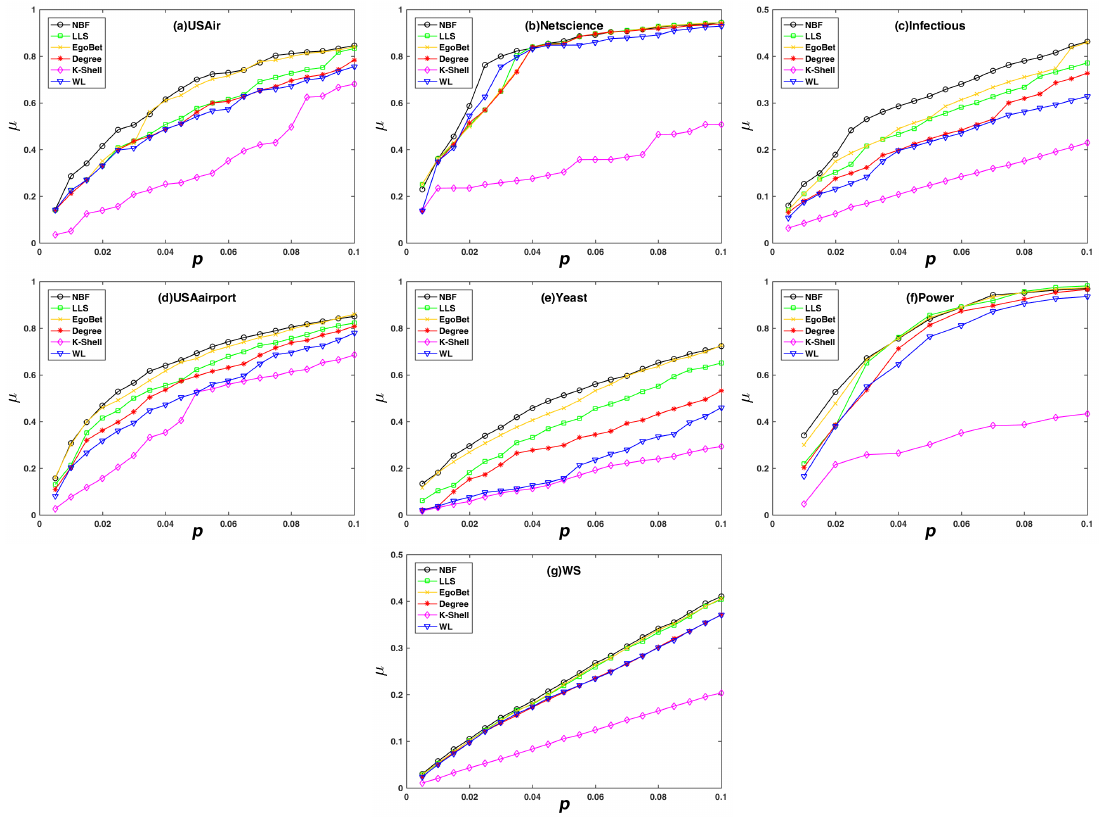
Figure 4. The decline rate of network efficiency ( µ ) subjects with different static attack strategies. The decline rate of network efficiency ( µ ) on the y -axis against the rate of removed node ( p ) on the x -axis. ( a ) the USAir network; ( b ) the Netscience network; ( c ) the Infectious network; ( d ) the USAirport network; ( e ) the Yeast network; ( f ) the Power network; ( g ) the synthetic network